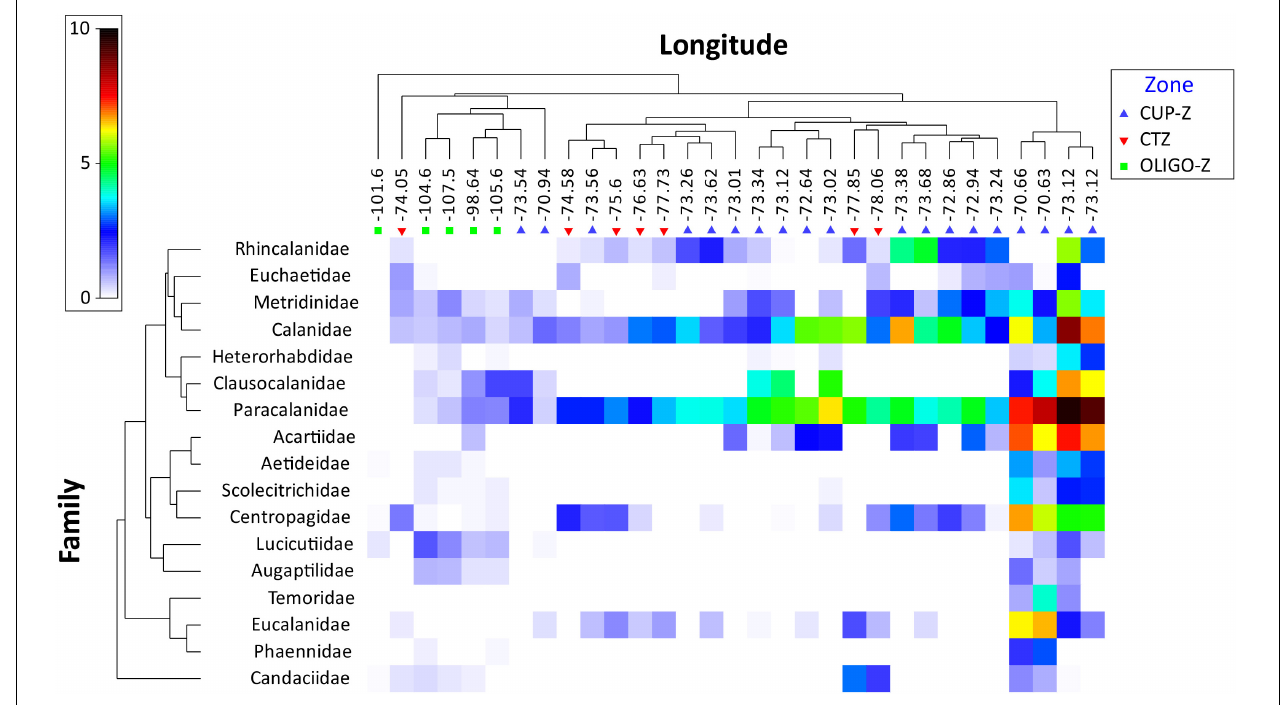
FIGURE 3 | Shade plot of mean abundances [transformed by log (x + 1)] of the 17 families found in the 0–200 m layer, along the onshore-offshore gradient from 2002 to 2015 in the southeast Pacific. Oceanographic zones are defined as: coastal upwelling zone (CUP-Z), mesotrophic coastal transition zone (CTZ) and oligotrophic zone (OLIGO-Z). The color scale represents transformed abundance for each